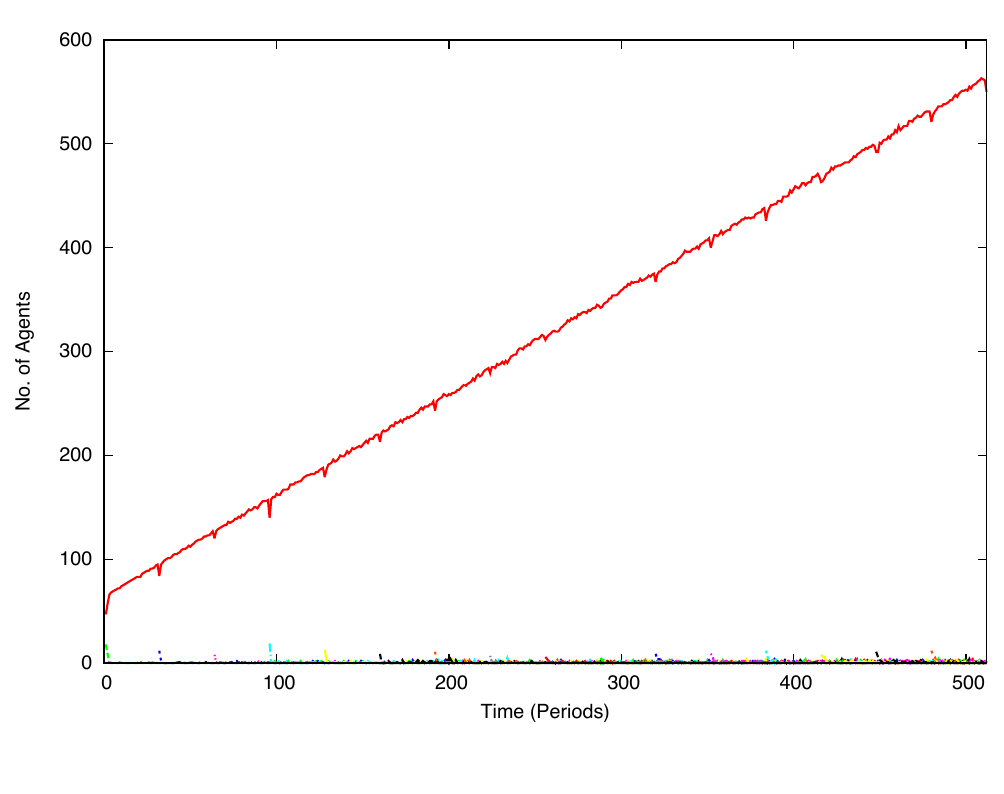
Figure 2. Development of the number of adherents to the different institutions (shown in different colors) for ↵ = 1 . 1